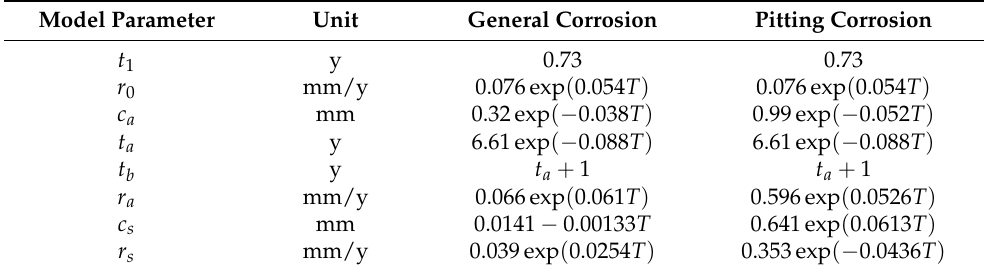
Table 1. Melchers general and pitting corrosion model parameters [19,23,27,28]. Model